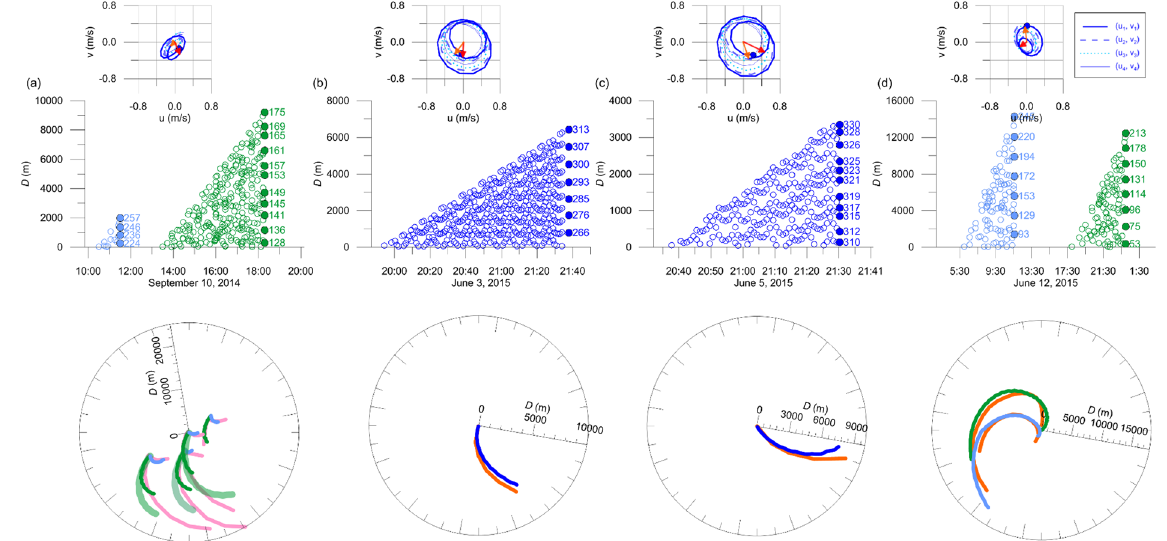
Figure 5. Time evolution of observed and modeled fronts of internal waves in the vicinity of the IORS. Time series of directional (subsampled) measures of distance D in meters (y-axis), from the topographic sill (origin) to the internal wave fronts as functions of time t (x-axis) and direction θ in degrees rotated counterclockwise from the east (numbers labeled in the right of filled circle symbols in the upper plots) for cases of ( a ) September 10, 2014, ( b ) June 3, ( c ) June 5, and ( d ) June 12, 2015. In the lower panel, surface expressions of leading internal wave fronts (( a ) from ‘A’ to ‘H’ in September 8–10, 2014; ( b ) ‘J’ in June 3, 2015; ( c ) ‘K’ in June 5, 2015; ( d ) ‘L’ and ‘M’ in June 12, 2015) observed by the SAR images (pink for 2014 and orange for 2015) and estimated (cyan and green for successive but distinct waves; ( a ) and ( e ), and blue for a single wave; ( b ) and ( c )) are compared in the polar coordinate. In ( a ) and ( d ), multiple local origins (arbitrarily shifted) are used for better comparisons. Thick green shaded lines in ( a ) denote the cases in which free wave speeds c i are doubled to show the sensitivity of the estimation to density stratification. In each panel, hodographs of horizontal current vectors at the IORS reproduced by the ROMS are shown above. They correspond to absolute horizontal (tidal plus subtidal) current vectors ( u i , v i ) at the four layers (centered at 5, 15, 25, and 35 m) of the station ( a ) from 22:00 UTC September 9 to 22:00 UTC September 10, 2014, ( b ) from 22:00:00 UTC June 2 to 22:00:00 UTC June 3, 2015, ( c ) from 22:00:00 UTC June 4 to 22:00:00 UTC June 5, 2015, and ( d ) from 22:00:00 UTC June 11 to 22:00:00 UTC June 12, 2015. Here, the surface layer current vectors ( u 1 , v 1 ) at the starting time, time of wave generation, and the SAR image acquisition time are remarked with blue circles, red arrows, and orange arrows,